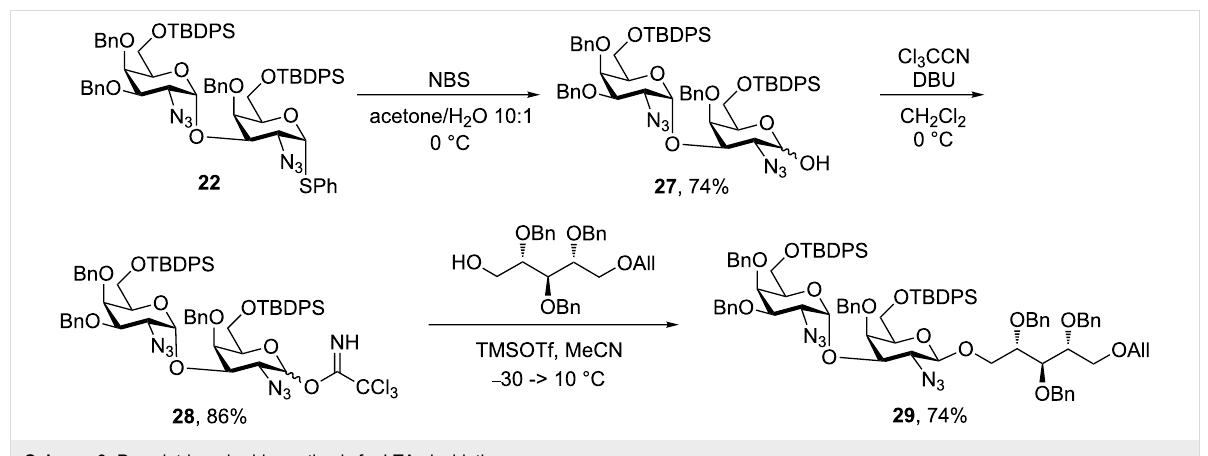
Scheme 6: Pseudotrisaccharide synthesis for LTA